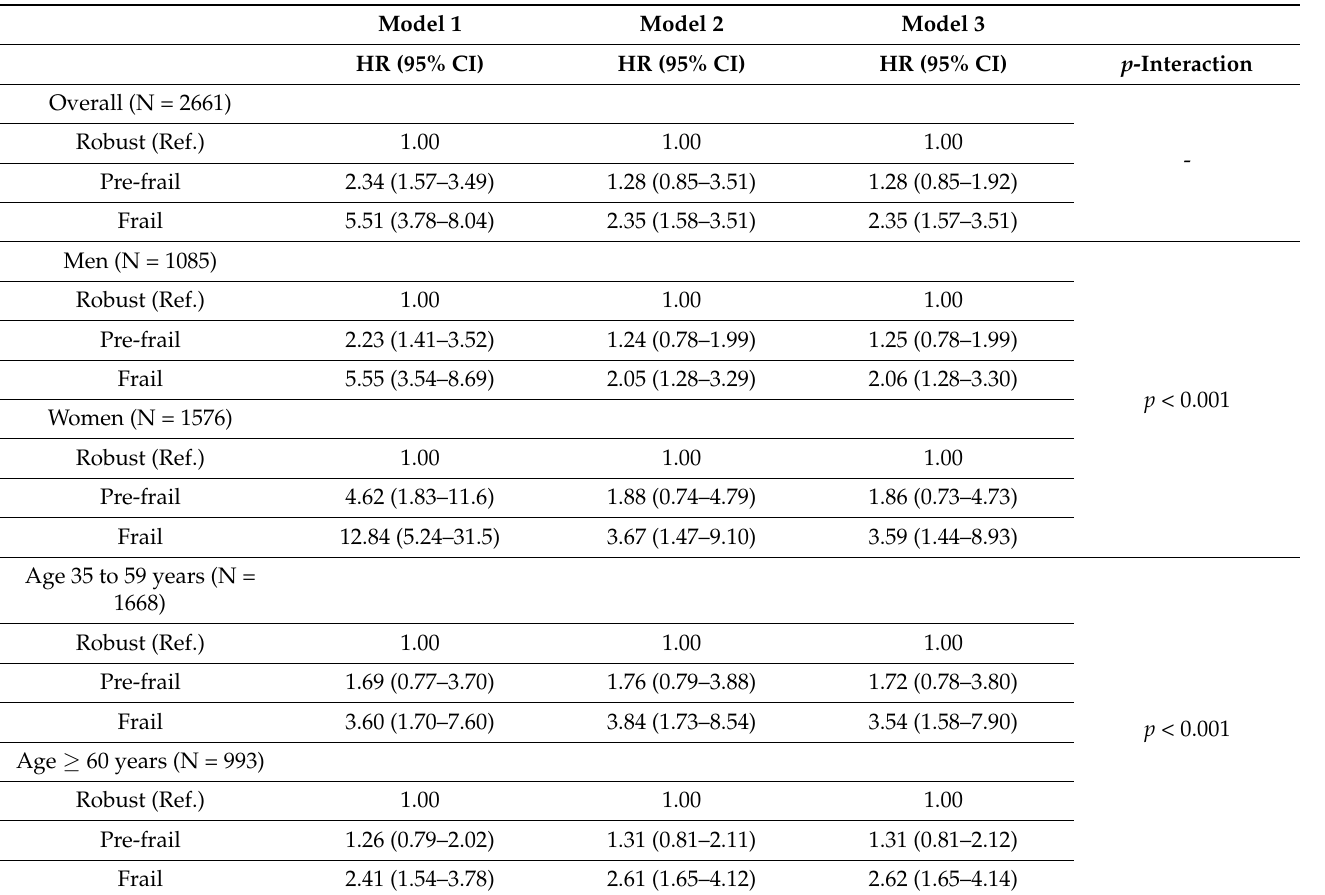
Table 2. Association between frailty status and risk of all-cause mortality by sex and age categories.